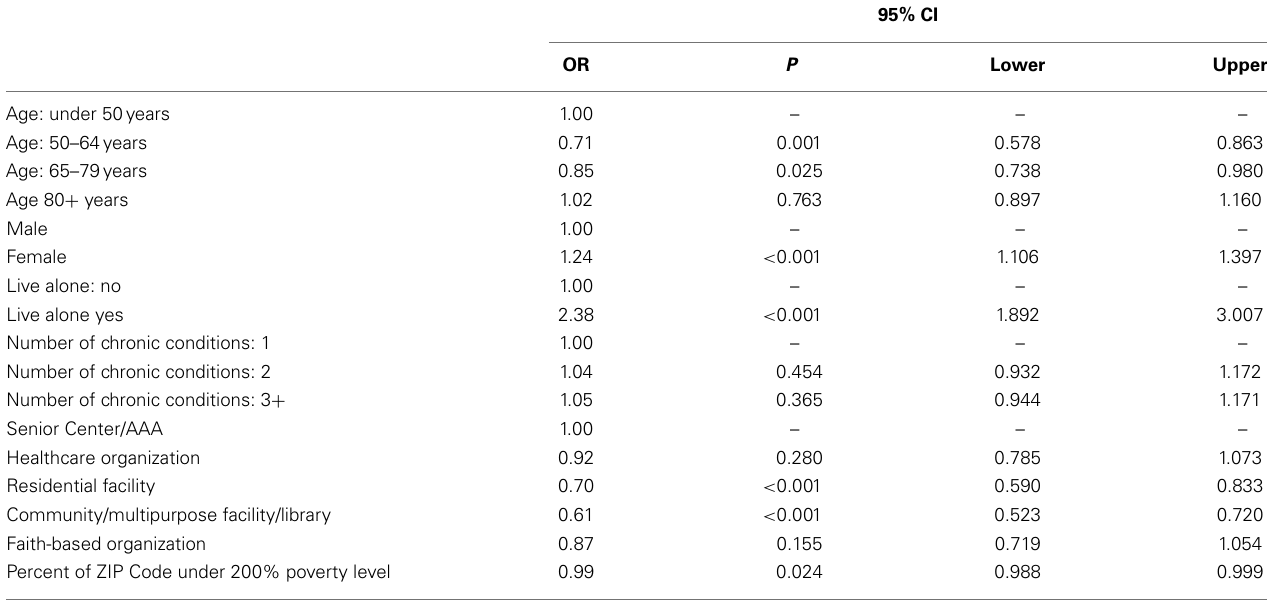
Table 2 | Factors associated with successful completion